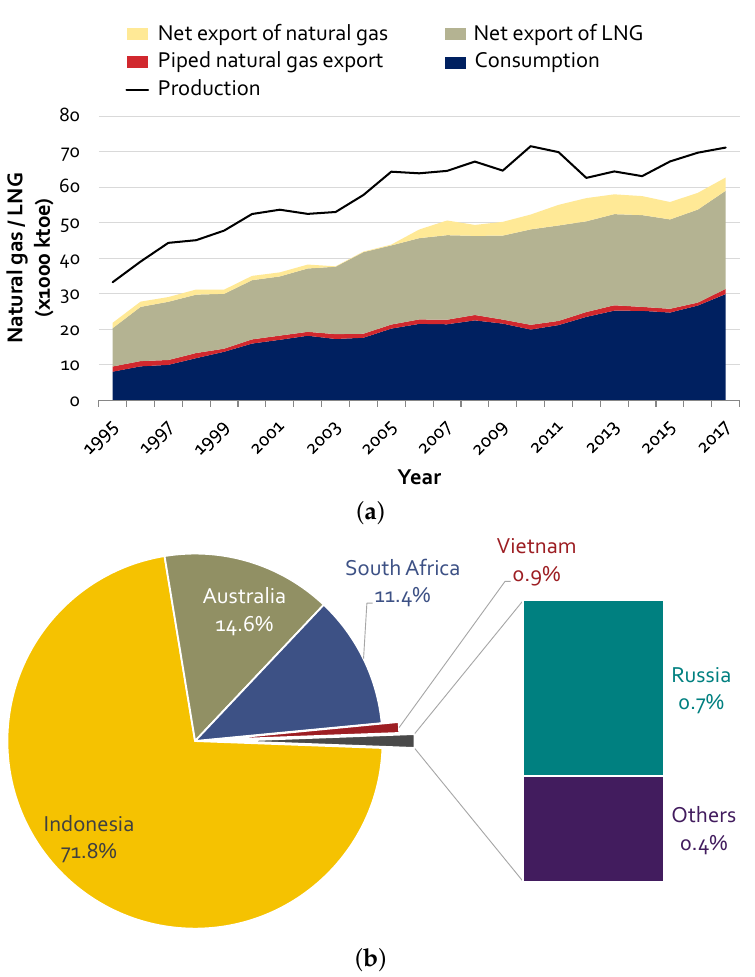
Figure 8. ( a ) Production, consumption, & net exports of natural gas [37]; ( b ) coal import by country, averaged between 2011 to 2013